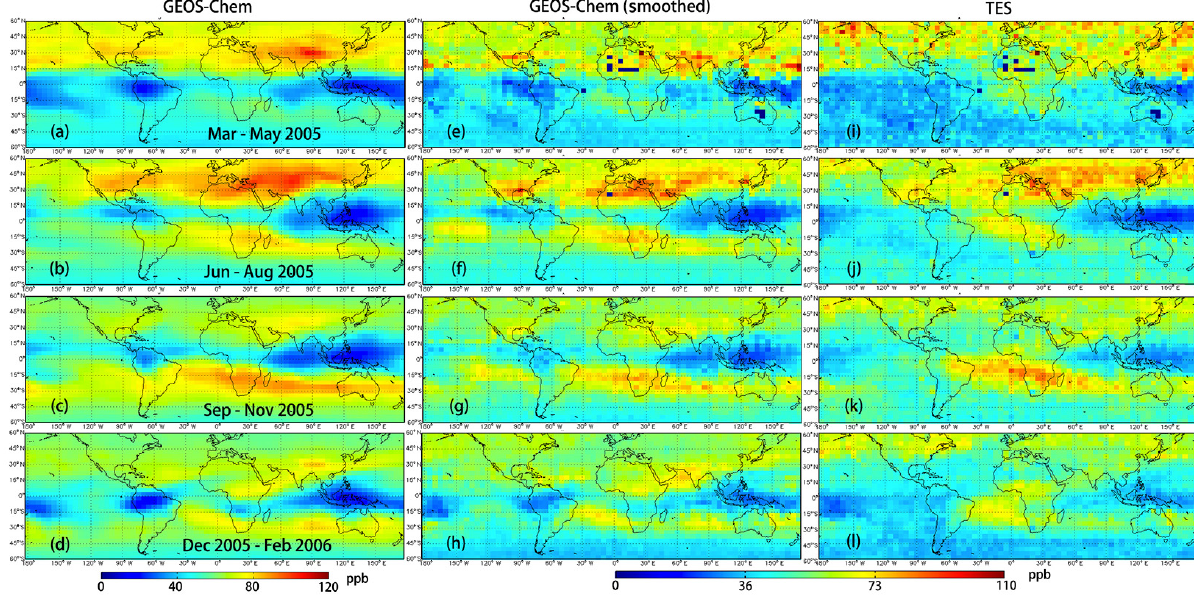
Figure 2. Seasonal mean middle free tropospheric O 3 (464hPa) in the period of March 2005–February 2006. (a–d) GEOS-Chem simulation. (e–h) GEOS-Chem simulation smoothed with TES averaging kernel and a priori. (i–l) TES O 3